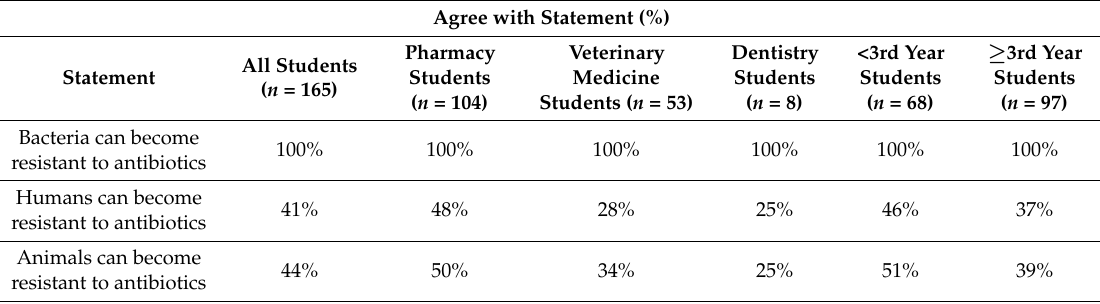
Table 1. Healthcare students’ awareness of what can become resistant to